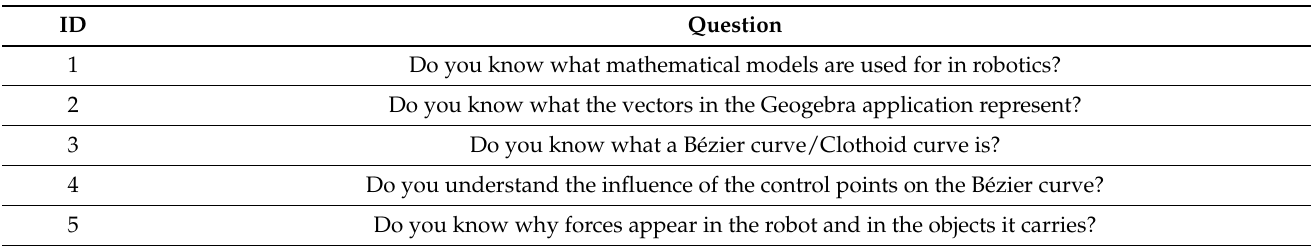
Table 4. Questionnaire answered by 1st year